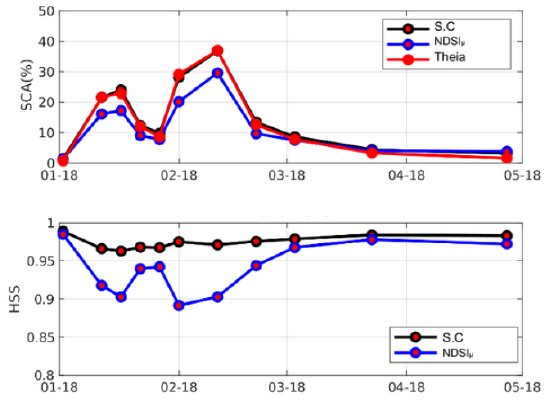
Figure 3. Results for the Pyrenees Sentinel-2 tile: temporal evolution of the snow cover fraction (SCA%) and Heidle skill score (HSS) from the supervised classification (SC), NDSI µ and the Theia snow product (used as a reference). The size of the tile is: 110 × 110 km 2 .